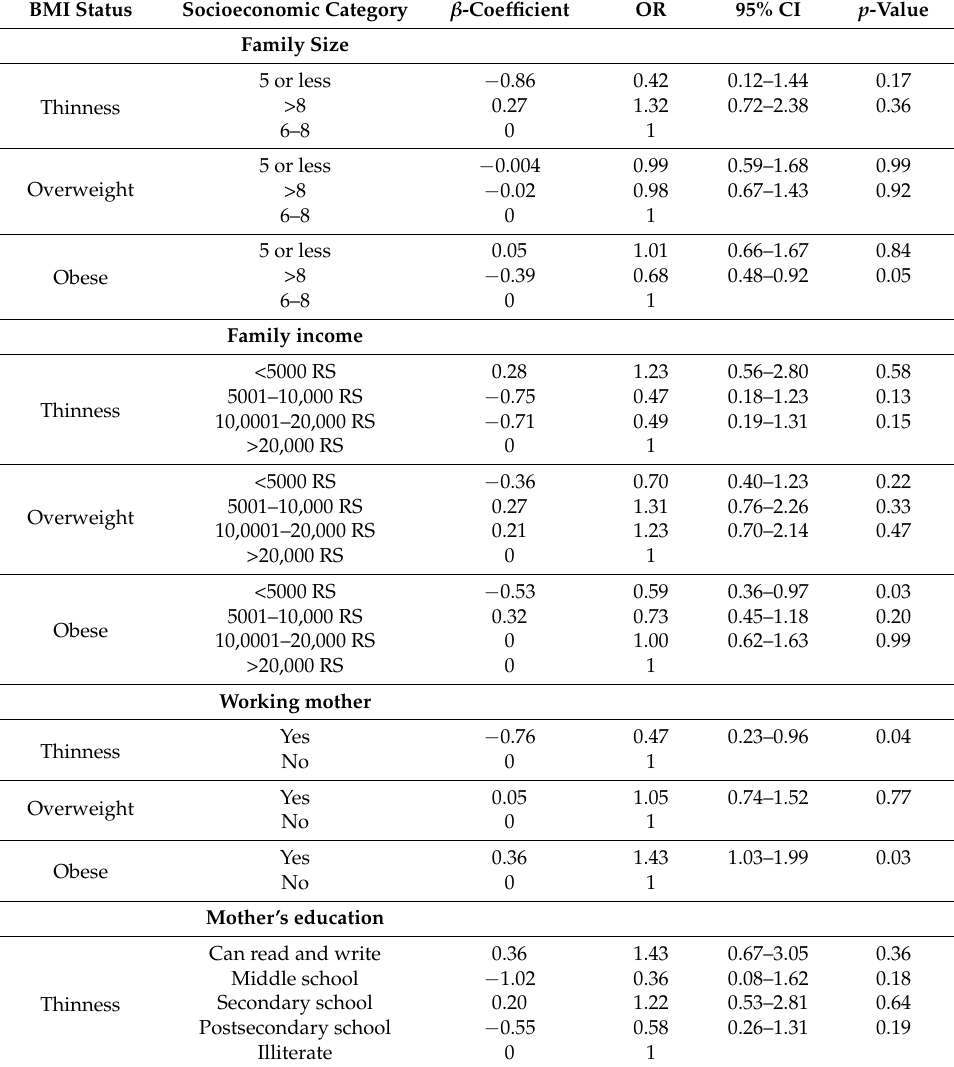
Table 3. Potential risks of socioeconomic factors on thinness, overweight, and obesity of adolescent male students